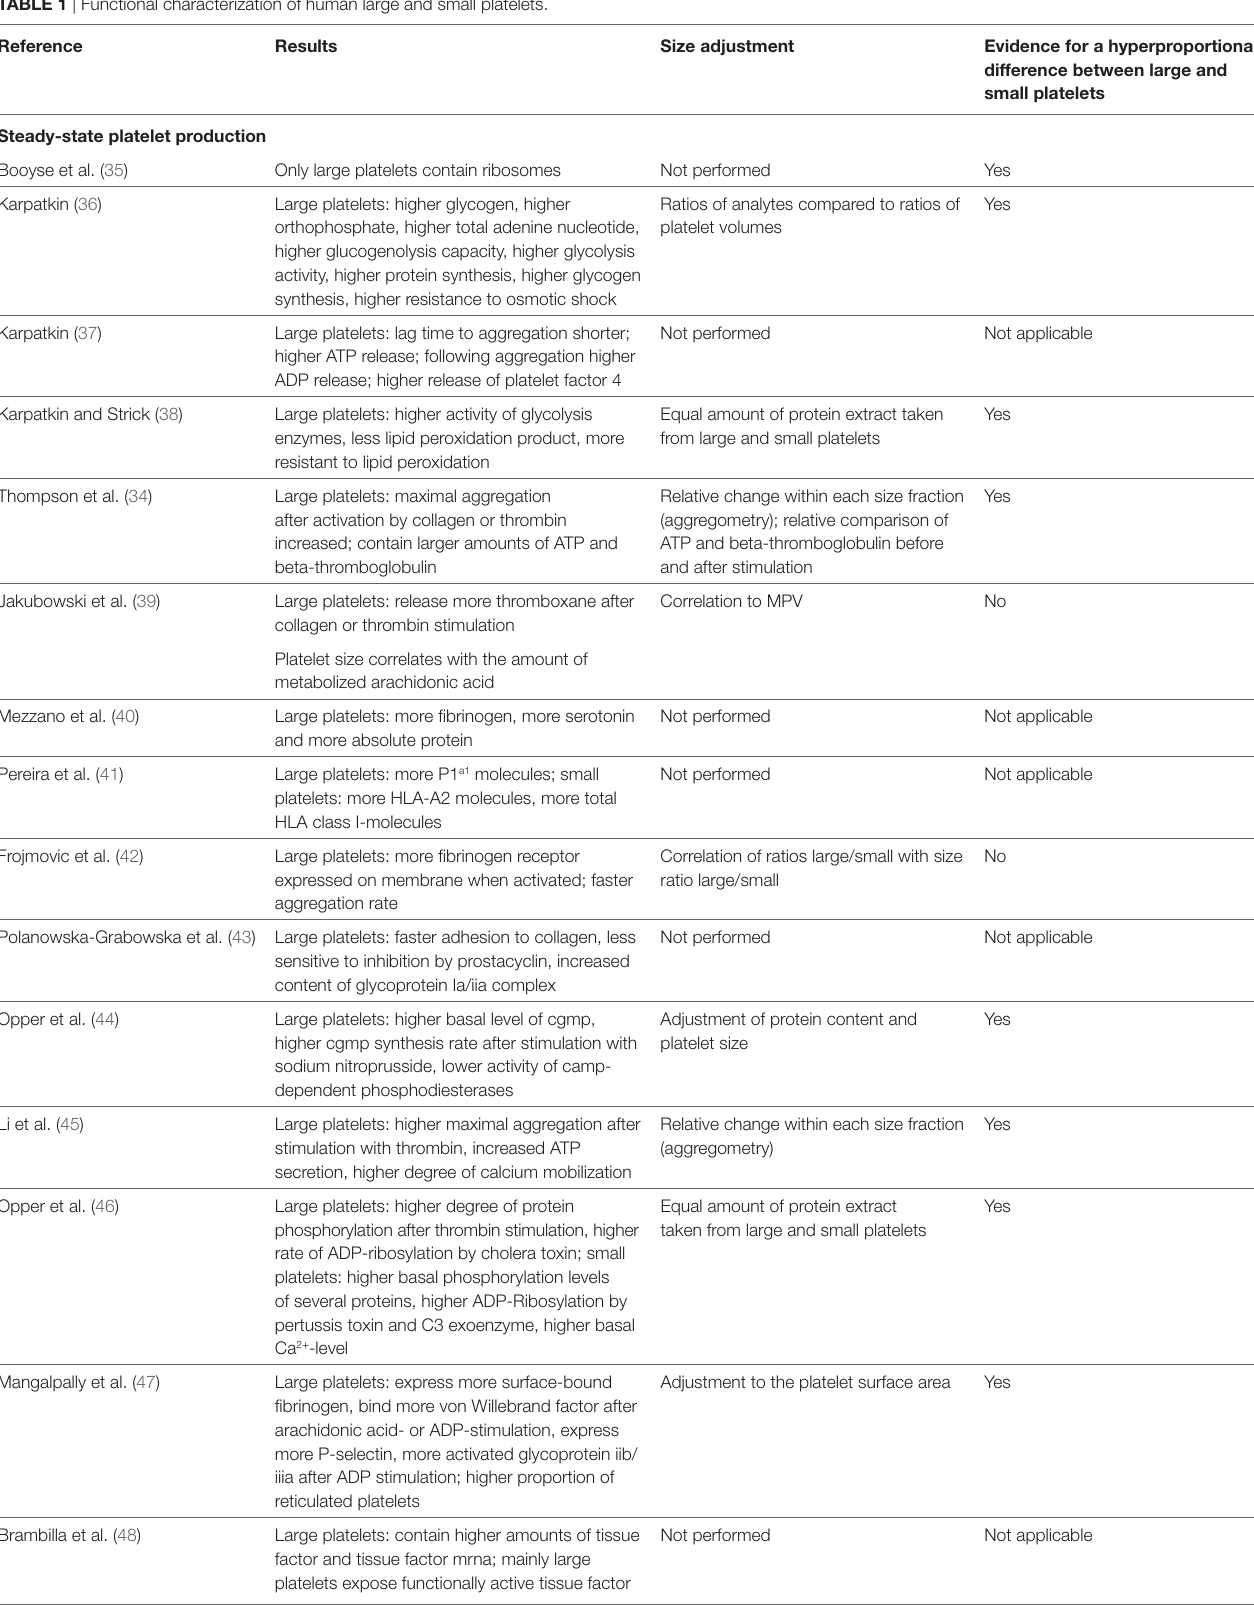
TAbLe 1 | Functional characterization of human large and small